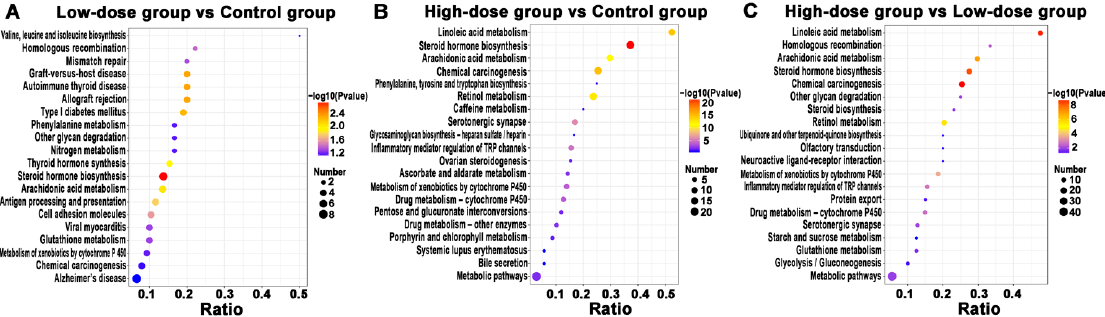
Figure 5. The KEGG pathway enrichment analysis of different groups. ( A ) low-dose group vs. control group. ( B ) high-dose group vs. control group; ( C ) high-dose vs. low-dose group. The abscissa represents the ratio of the number of differential proteins associated with the pathway to the number of background (all) proteins associated with the pathway. The redder the bubble represents the smaller the p value, the bluer the bubble represents the larger the p value and the larger the bubble represents the more differential proteins detected.